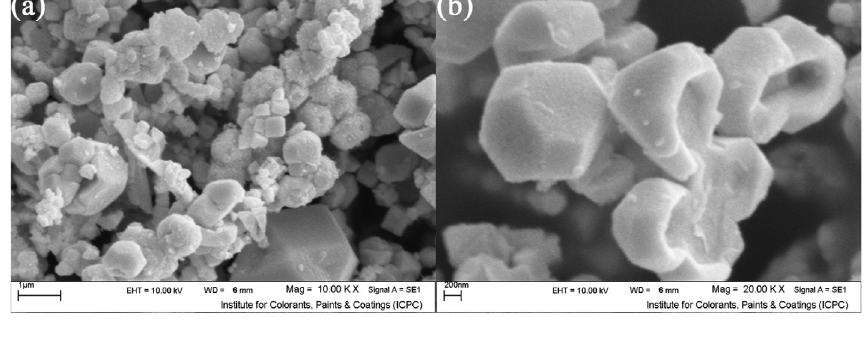
Figure 11 (a, b): SEM image of sample no. 3 with 10 KX and 20 KX magnification, respectively.